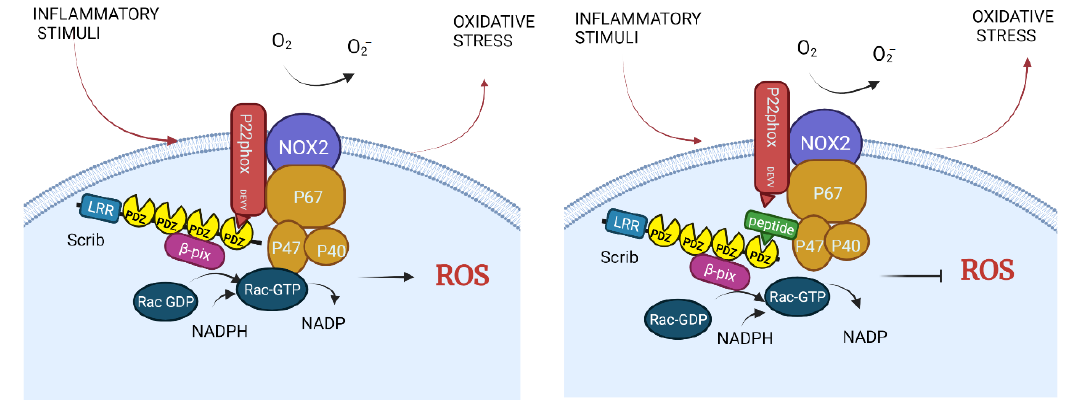
Figure 4. NADPH oxidase (Nox) complex activation depends on a PDZ interaction. The PDZ protein Scrib assembles the NADPH oxidase (Nox) complex through the interaction with the PDZbm (DEVV) in the p22phox subunit, producing ROS (left). The ROS production could be inhibited with a peptide that blocks the binding of DEVV with the PDZ4 domain of Scrib (right).